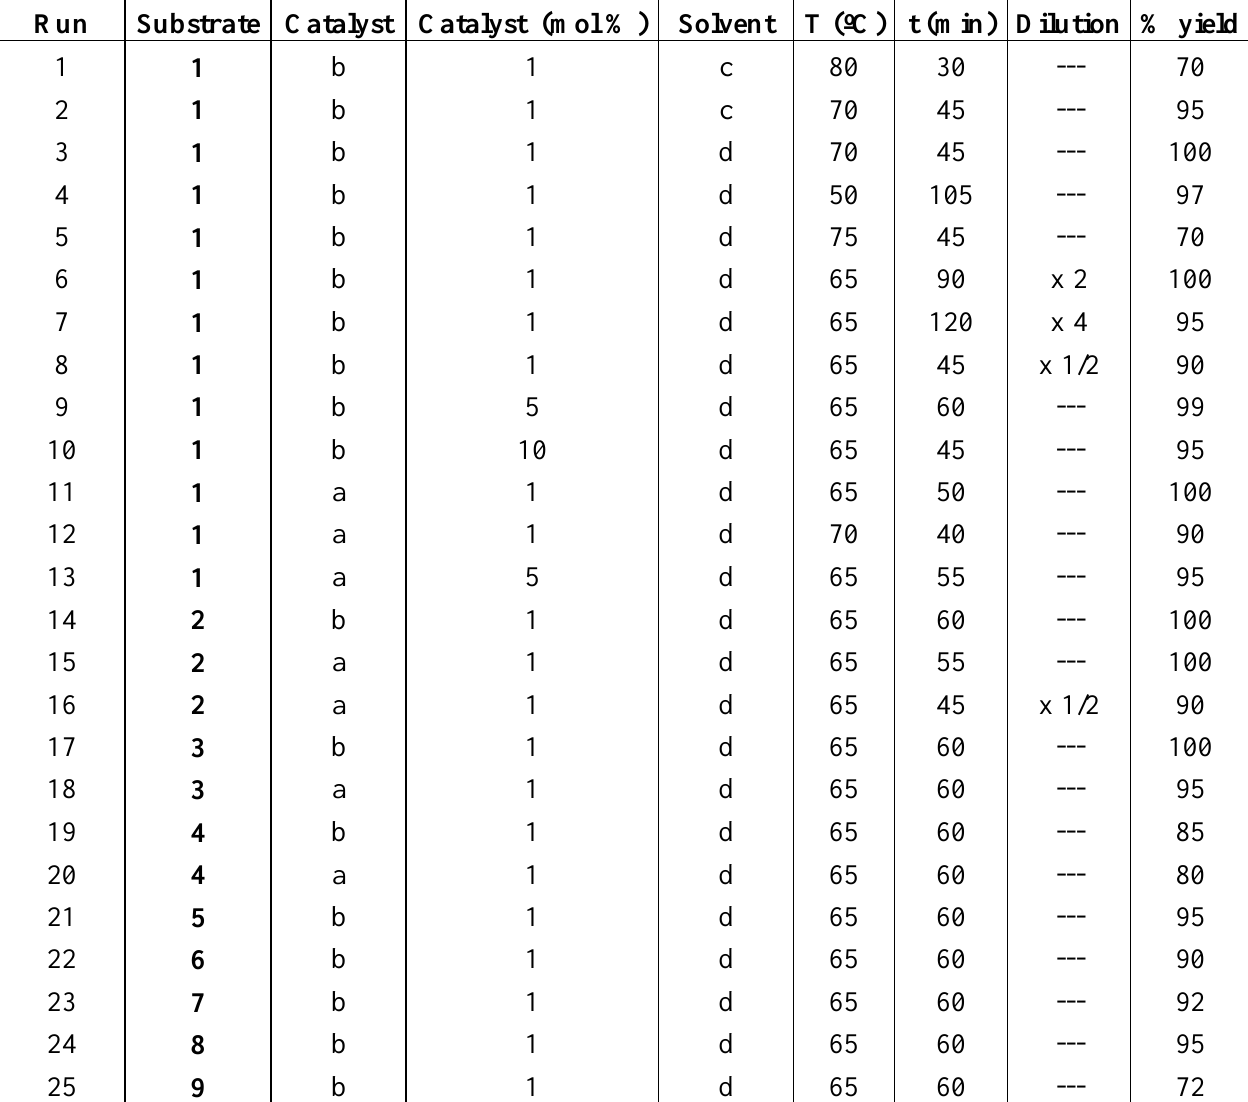
Table 2. Deprotection using supported Well-Dawson